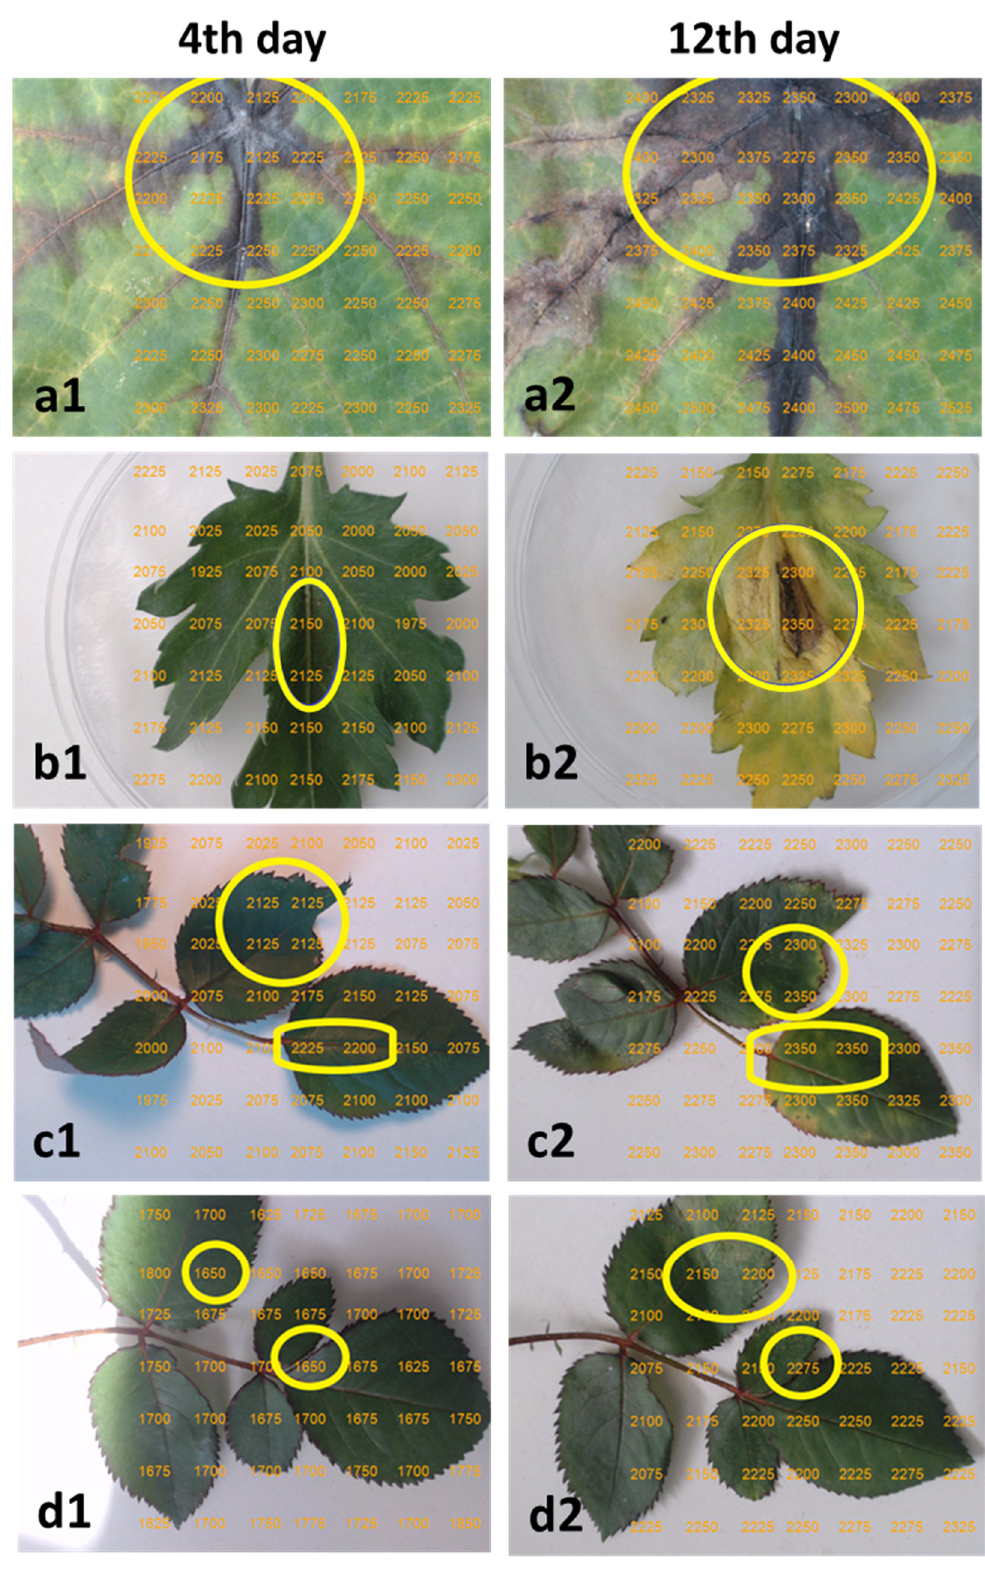
Figure 5. TRGB images 4 and twelve 12 days after infection, infection or inoculation from: ( a1 , a2 ) vine leaves infected with Phomopsis viticola ; ( b1 , b2 ) chrysanthemum leaves inoculated with Septoria ssp., mycelium; ( c1 , c2 ) rose leaves inoculated with Colletotrichum spp., conidia; ( d1 , d2 ) rose leaves infected with Podosphaera pannosa conidia.